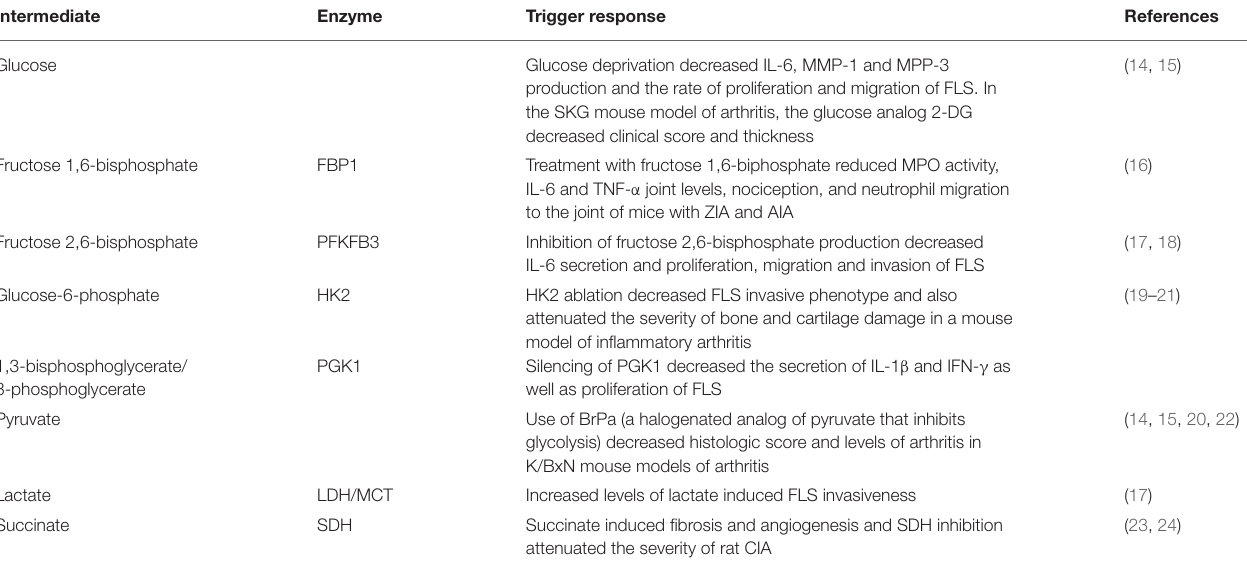
TABLE 1 | Glycolyitic intermediate metabolites and their effect on RA FLS and animal models of arthritis.